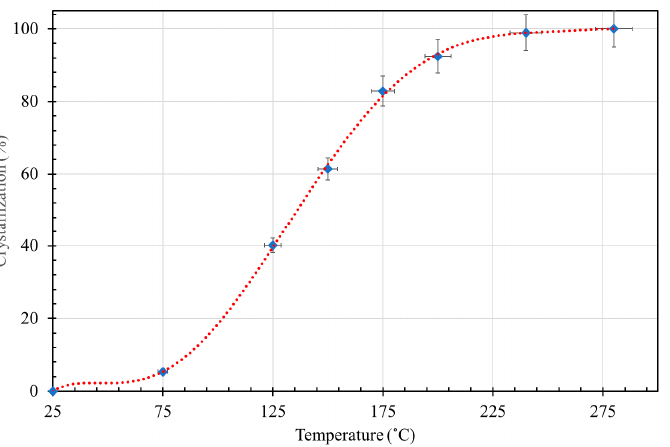
Figure 5. Percentage of saponite crystallization as a function of synthesis temperature (modified after [25]).